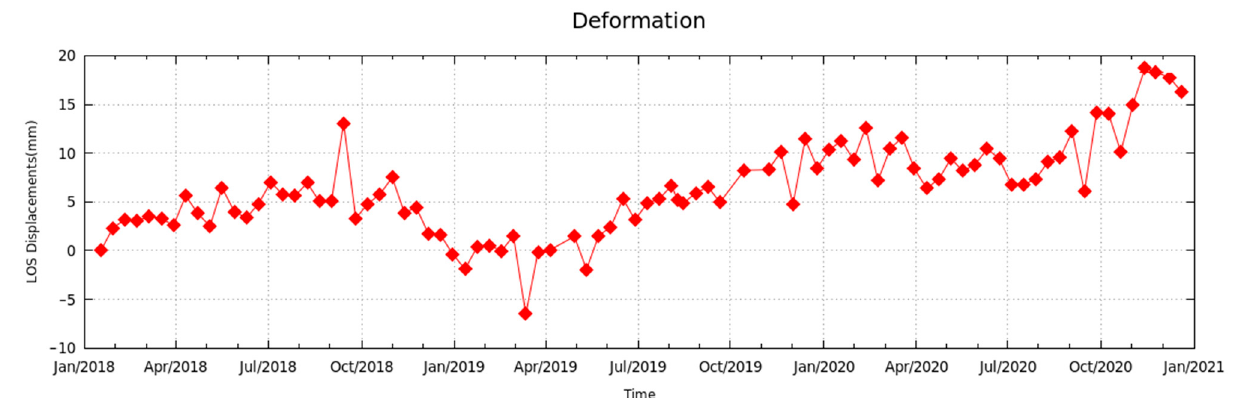
Figure 14. Deformation of point P4 during the monitoring period.